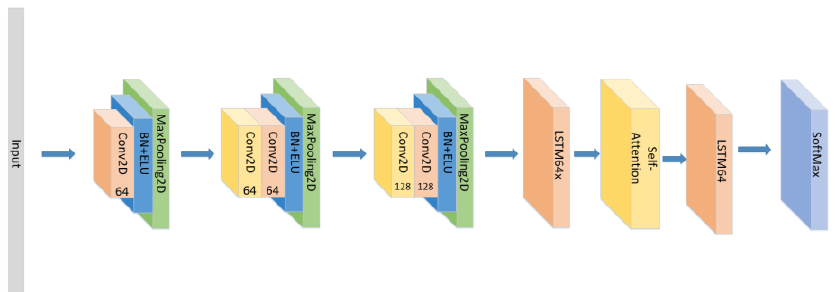
Figure 9. The construction of the CNN+LSTM+Self-Attention+LSTM model. (6) Set the CNN network with the same parameters and the same number of layers as the original model with the Self-Attention as shown in Figure 10. Figure 10. The construction of the CNN+Self-Attention model. (7) Set the CNN network with the same parameters and the same number of layers as the original model with the Self-Attention as shown in Figure 11.